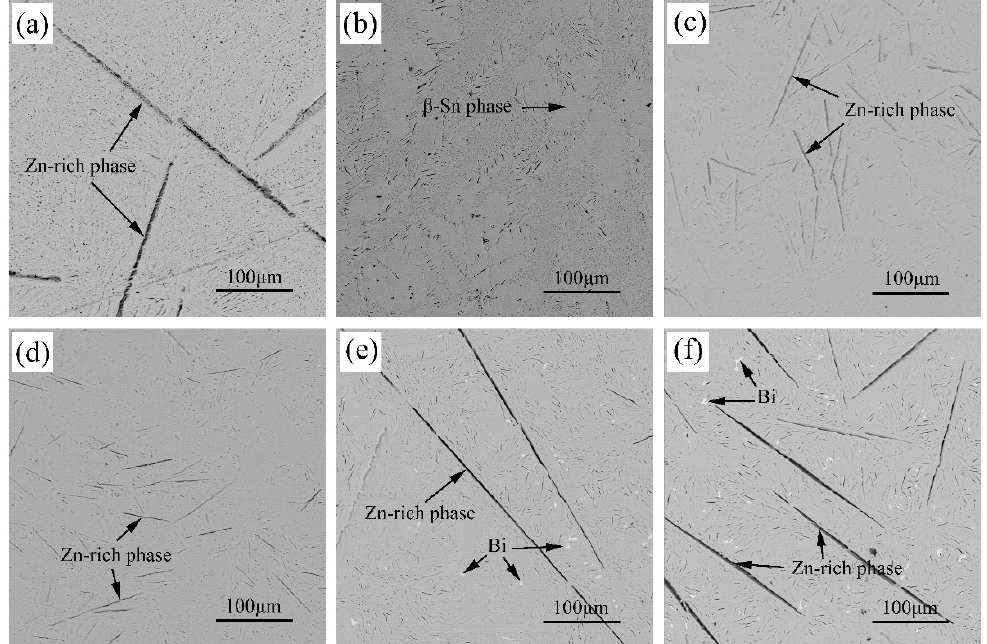
Figure 2. Back-scattered electron (BSE) images of Sn-9Zn-xBi solder alloys: ( a ) Sn-9Zn; ( b ) S n-9Zn-1Bi; ( c ) Sn-9Zn-2Bi; ( d ) Sn-9Zn-3Bi; ( e ) Sn-9Zn-4Bi; ( f ) Sn-9Zn-5Bi.